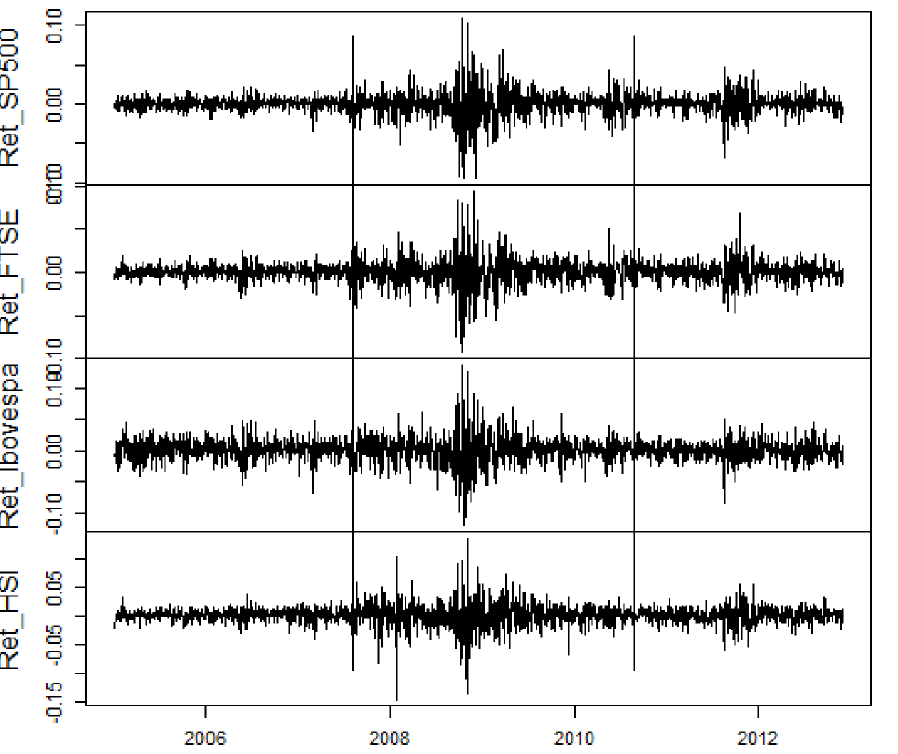
Figure 2. Daily log-returns of S&P500, FTSE100, Ibovespa and HSI from January 2005 to November 2012. Vertical lines represent the subdivision into non-crisis, Sub-prime crisis and Eurozone crisis.